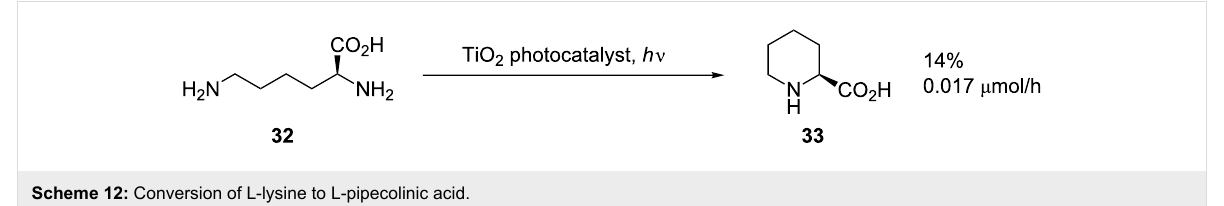
Scheme 12: Conversion of L-lysine to L-pipecolinic acid.